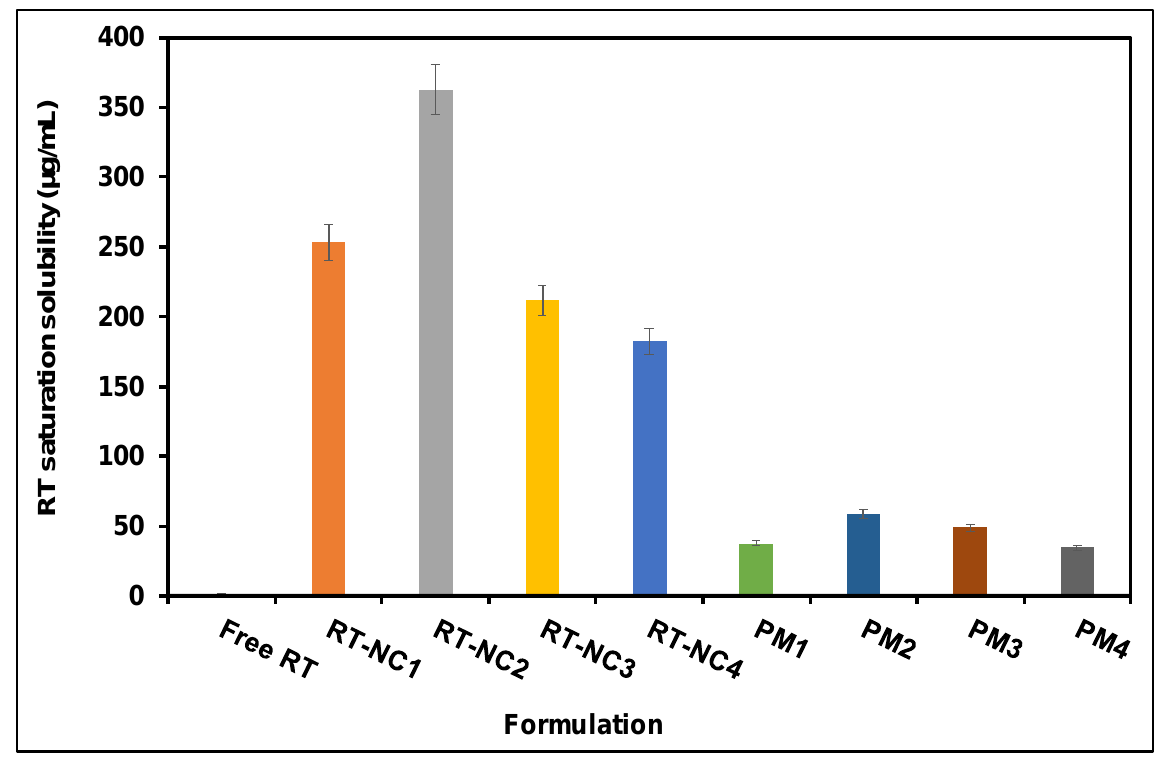
Figure 3. Saturation solubility of various RT-NCs in phosphate buffer pH 6.5 in comparison to free RT and various corresponding physical mixtures (PM). RT-NC1: rutin nanocrystals formulation 1, RT-NC2: rutin nanocrystals formulation 2, RT-NC3: rutin nanocrystals formulation 3, RT-NC4: rutin nanocrystals formulation 4.